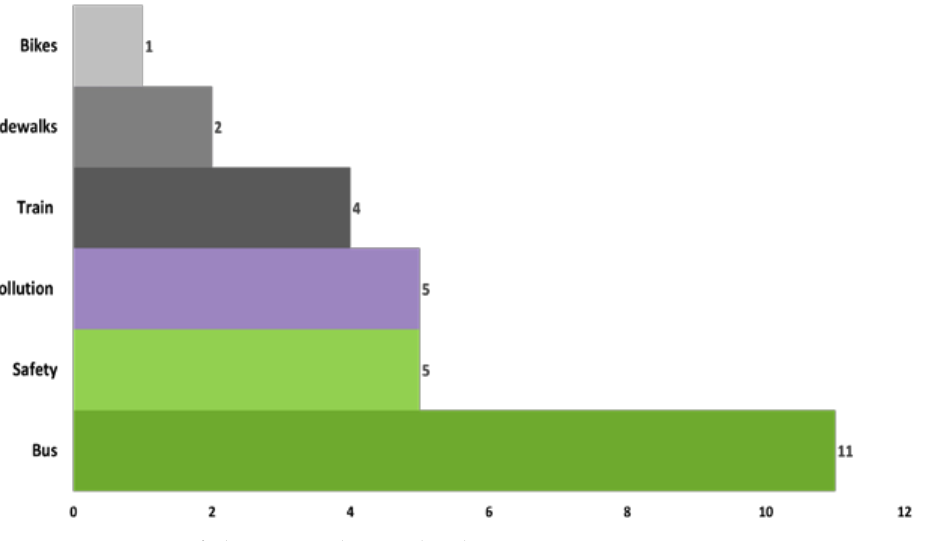
Figure 1. Summary of photovoice photos related to transportation.